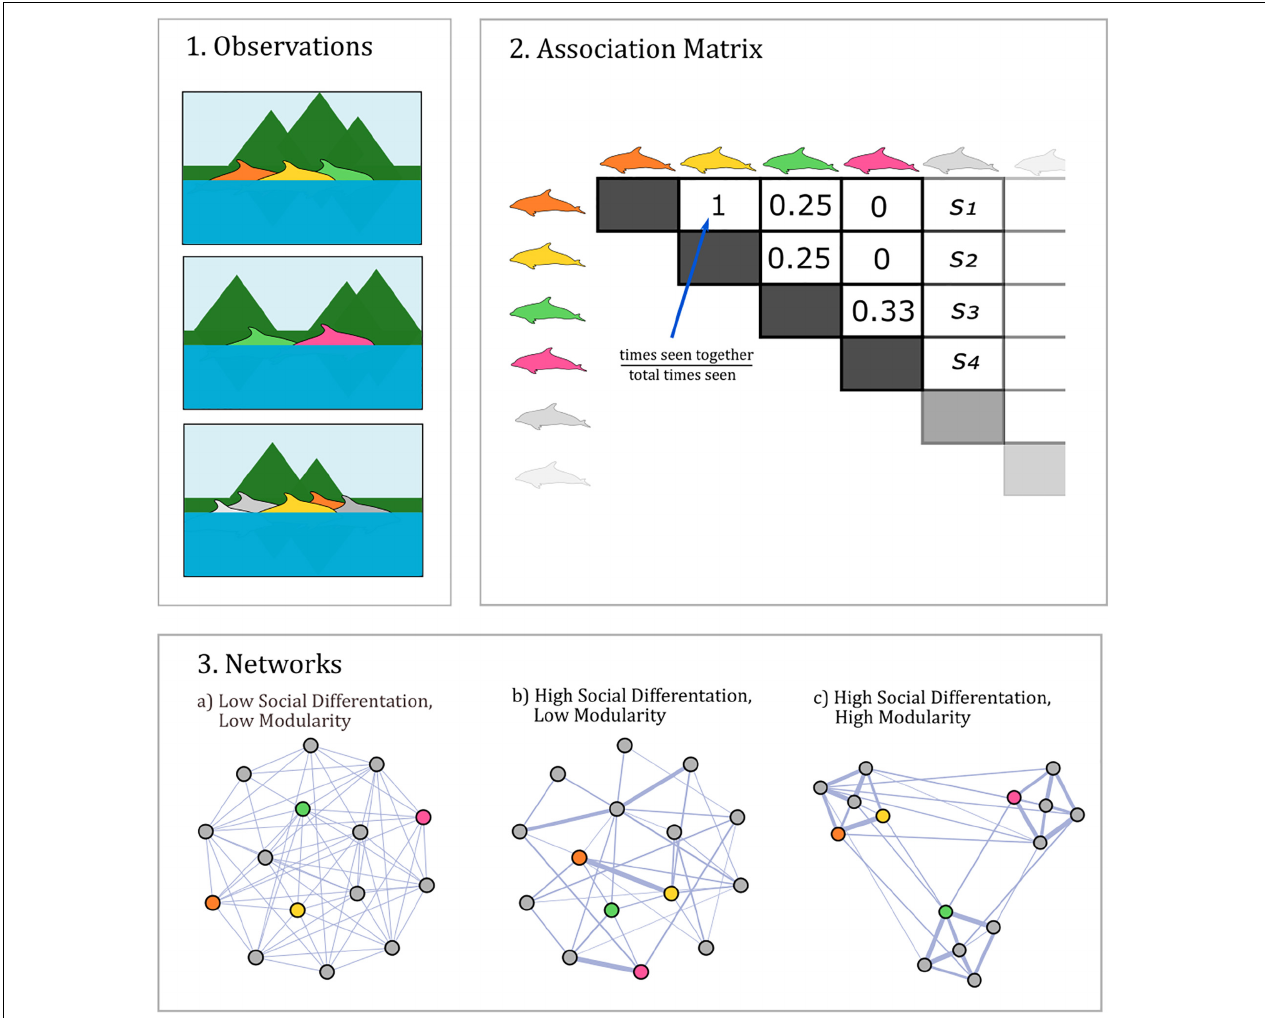
FIGURE 1 | Measuring and analysing toothed whale social networks. Associations between individuals are typically derived from repeated photo-ID surveys (1). These samples are used to generate pairwise association indices between individuals and a corresponding association matrix (2). These matrices can be analysed as weighted social networks to quantify aspects of social structure, such as social differentiation and modularity (3). Dolphin silhouettes are by Chris Huh, re-used here with alteration under a Creative Commons Share-alike license